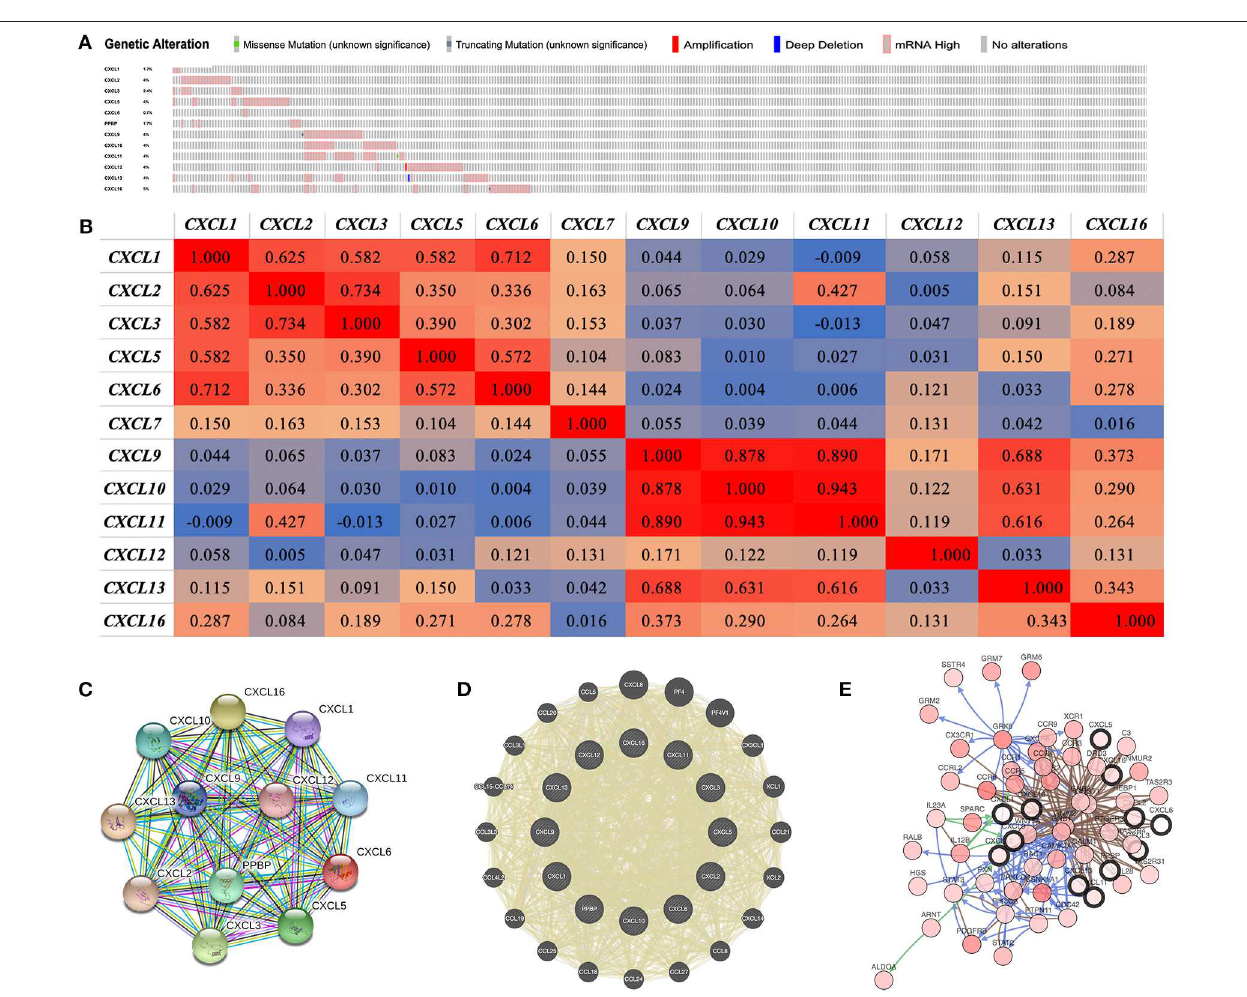
EPHB FWD pathway, the PID integrin-linked kinase (ILK) ( Supplementary Figure 1E